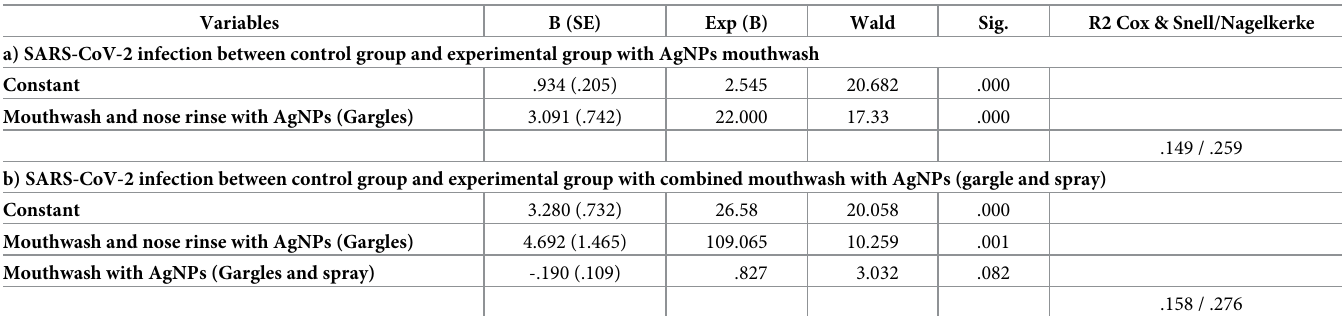
Table 3. Results of the logistic regression of SARS-CoV-2 infection between control and experimental groups. Variables